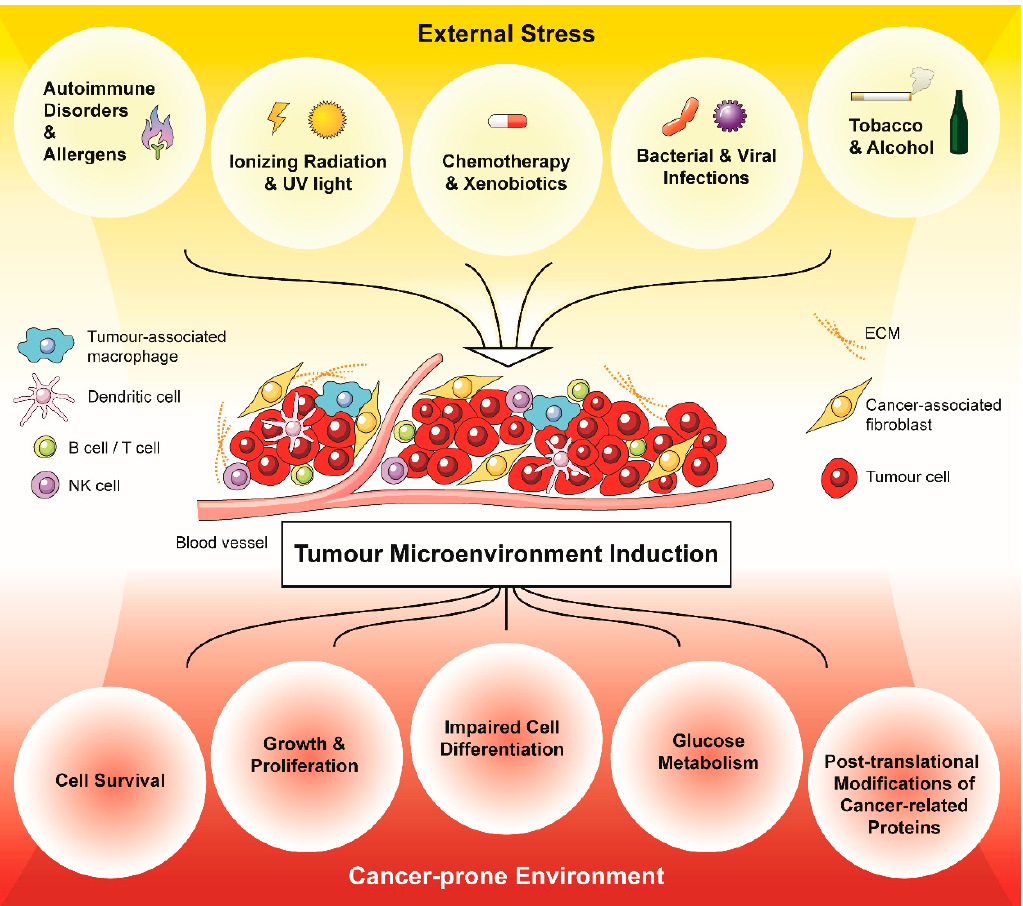
Figure 1. External stressors promote and drive a cancer-prone environment via the generation of oxidative stress in a tumour microenvironment (TME). Acute and chronic stressors generate oxidative stress in the form of ROS within the TME, which affects the composition of the tumour-associated stroma. In turn, the stress-induced tumour-associated stroma promotes cancer cell survival, growth and proliferation, impaired cell differentiation, glucose metabolism and post-translational modifications of cancer-related proteins.